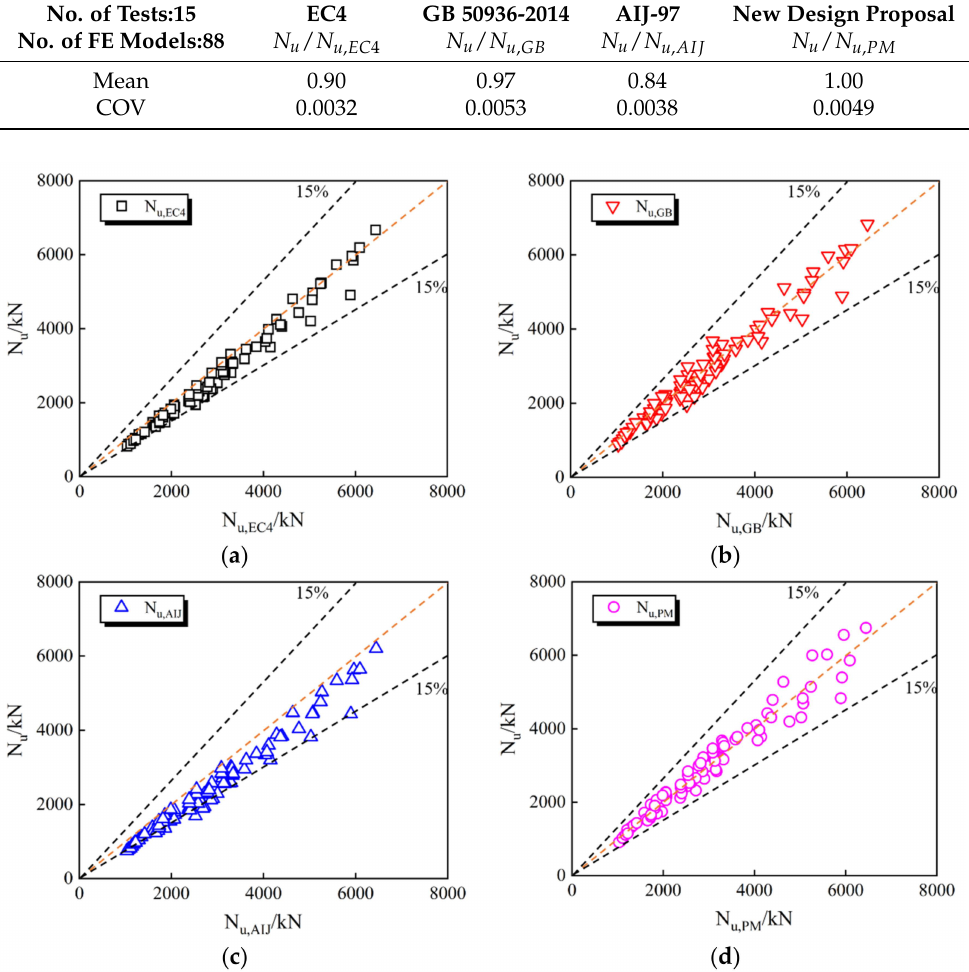
Figure 15. Compared with the results of the experiment and FE. ( a ) Comparison of test and FE results with predicted results of EC4. ( b ) Comparison of test and FE results with predicted results of GB 50936-2014. ( c ) Comparison of test and FE results with predicted results of AIJ-97. ( d ) Comparison of test and FE results with predicted results of the new design